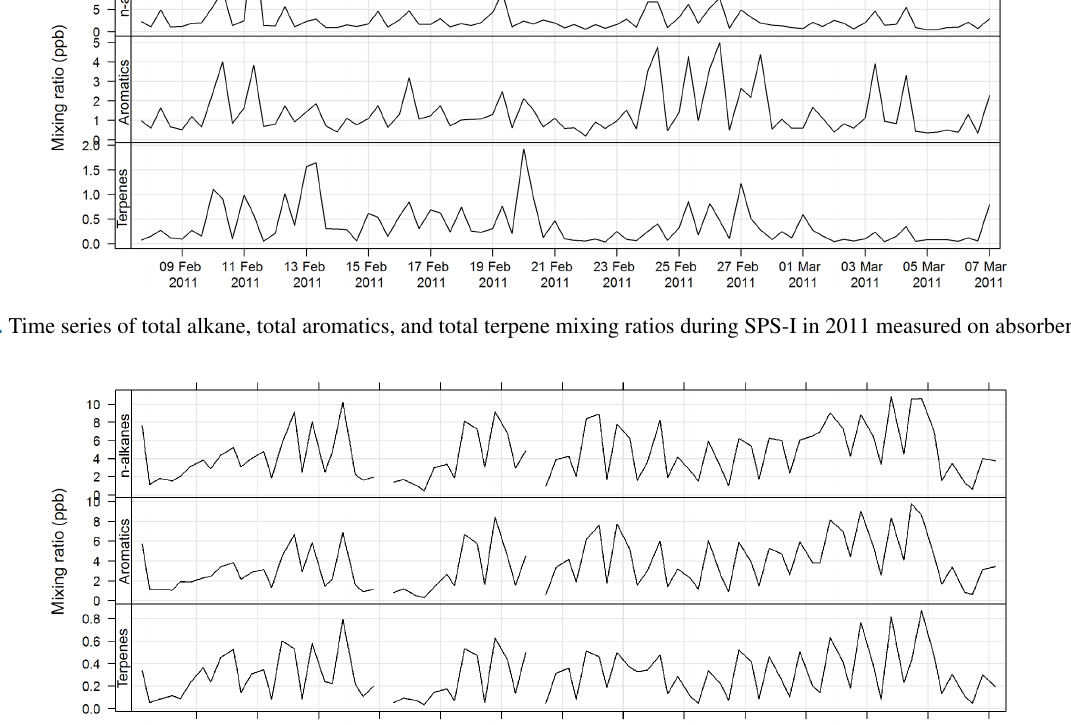
ceptor modelling methodologies can be used to apportion sources to the aerosol loadings (Norris et al., 2008). Dur- ing both SPS-I and SPS-II 30 samples were collected in the mornings and 30 in the afternoons. Hence with only 60 sam- ples for each sampling period, we are restricted to a quali- tative and rudimentary assessment of aerosol sources utiliz- ing information on relationships between some key marker species and the timing of their